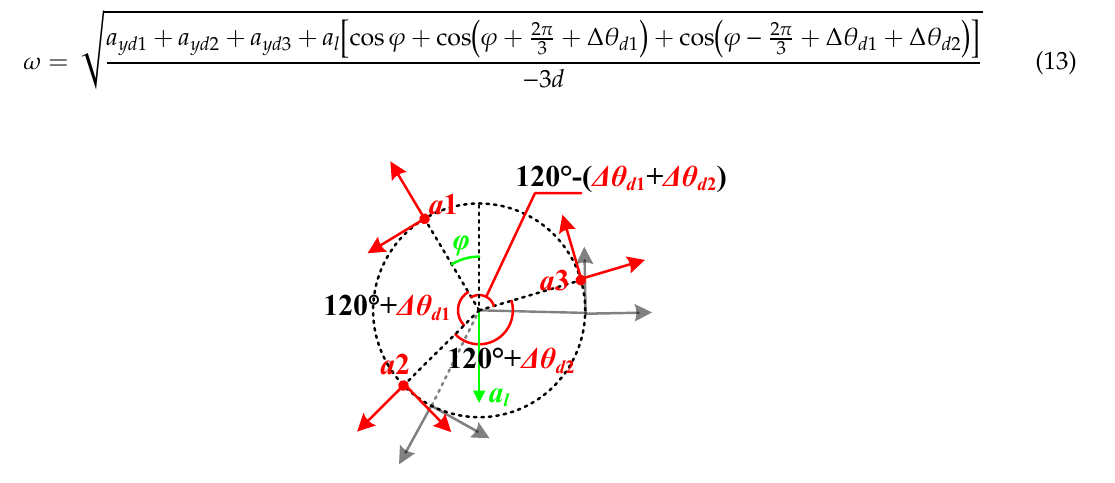
Figure 5. Description of the angular distribution error.